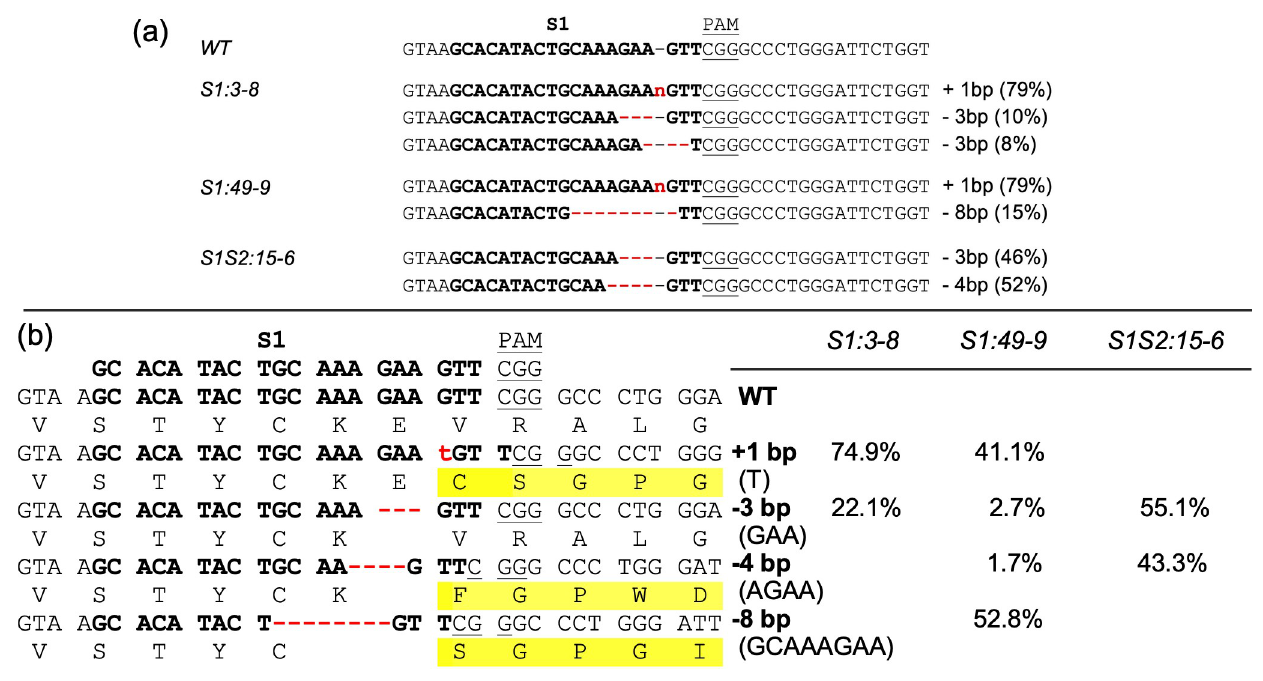
Fig 5. Mutations in transgene-free T1 plants at the sgRNA1 (S1) target site and the resulted amino acid sequence changes. (a) Indel types and the corresponding percentages in indicated T1 plants, detected using ICE v2 bioinformatic tool. (b) Mutations, the resultant amino acid sequence changes, and the corresponding percentage of reads, determined by amplicon deep sequencing. WT, the shown sequence fragment derived from the wild-type plant. The 20-nt S1 target sequence is shown in bold and the PAM underlined. The insertions are shown in red letter in lower case. “n” represents an inserted nucleotide that ICE v2 algorithm did not specify. The deletions are shown in red dashed lines.